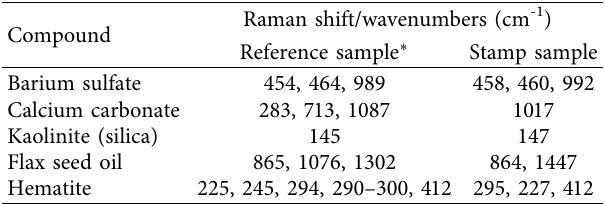
Table 3: Raman spectra from the reference and red stamp